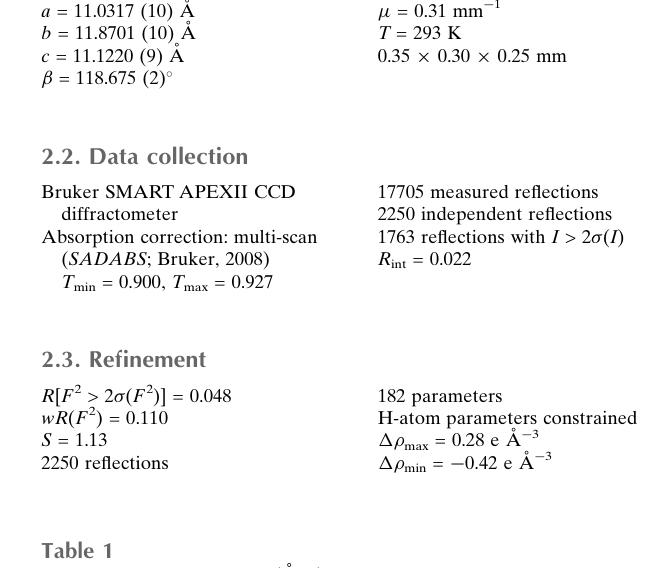
Hydrogen-bond geometry (A˚ , (cid:2)